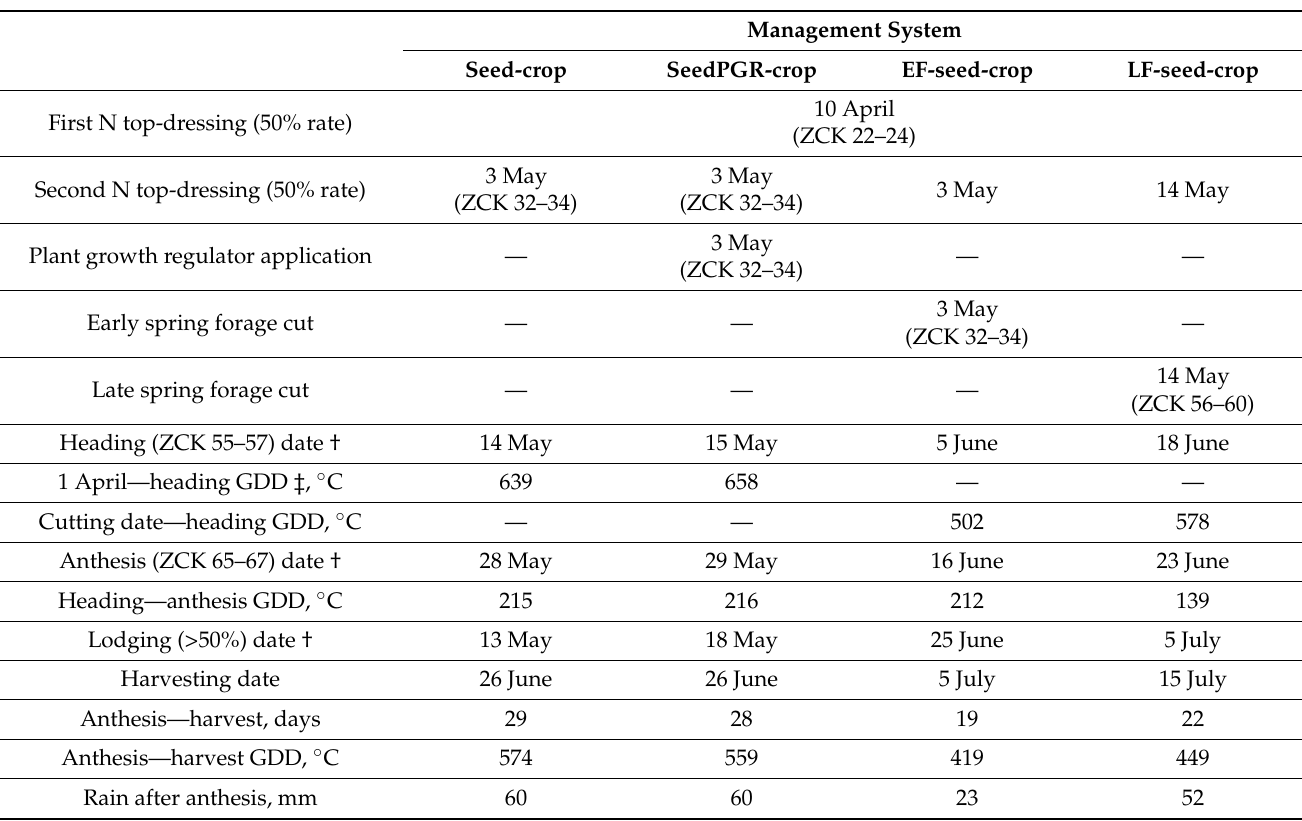
Table 2. Summary of management, ZCK growth stages, and weather conditions for the second production year of biannual Italian ryegrass grown for seed